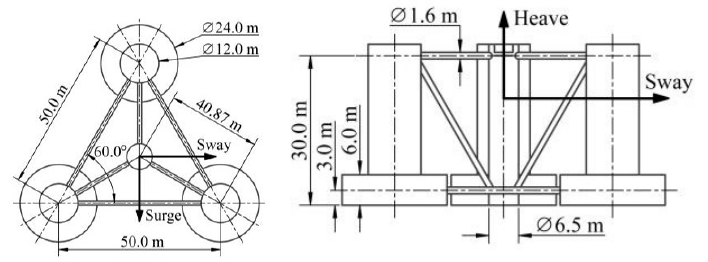
Figure 3. Plan ( left ) and side ( right ) view of DeepCwind semi-submersible platform [2]. Table 1. Turbine characteristics